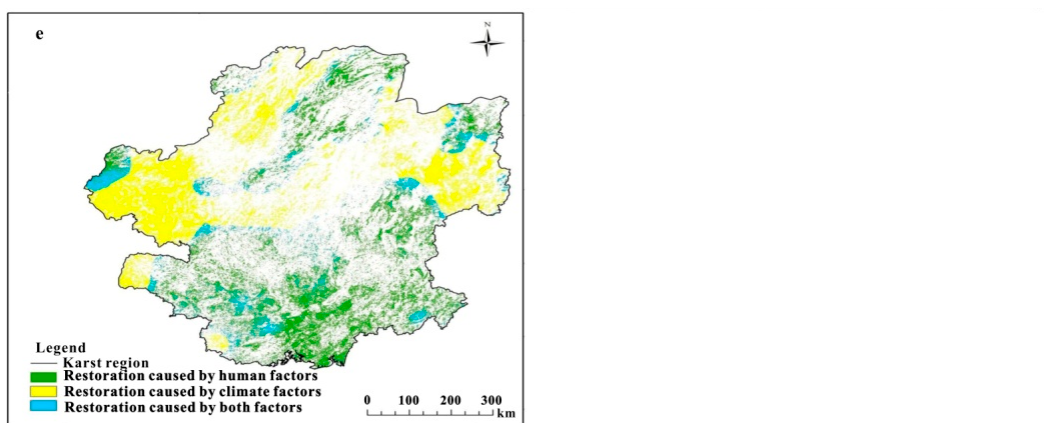
Figure 3. Spatial distribution of vegetation restoration caused by different factors in the Northern Wind-sand region ( a ), Loess Plateau region ( b ), Arid Desert region ( c ), Tibetan Plateau region ( d ), and Karst region ( e ) from 2000 to 2015. Forests 2018 , 9 , x FOR PEER REVIEW